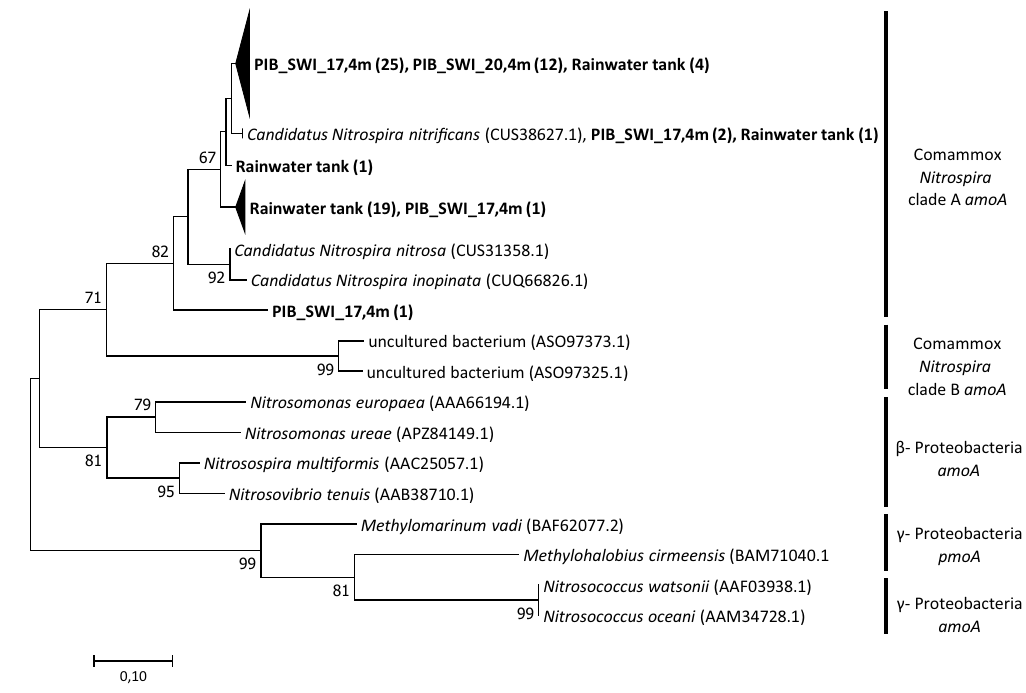
Figure 2. Neighbor-Joining tree of Comammox amoA sequences generated with the newly designed ComaA1A2_336F/497R primer set. The tree is based on deduced amino acid sequences of amoA genes obtained in this study (shown in bold) and representative reference sequences from NCBI database. Numbers in parentheses indicate the number of sequences. Bootstrap values are shown as percentages of 1000 replicates, values over 50% are indicated on nodes.